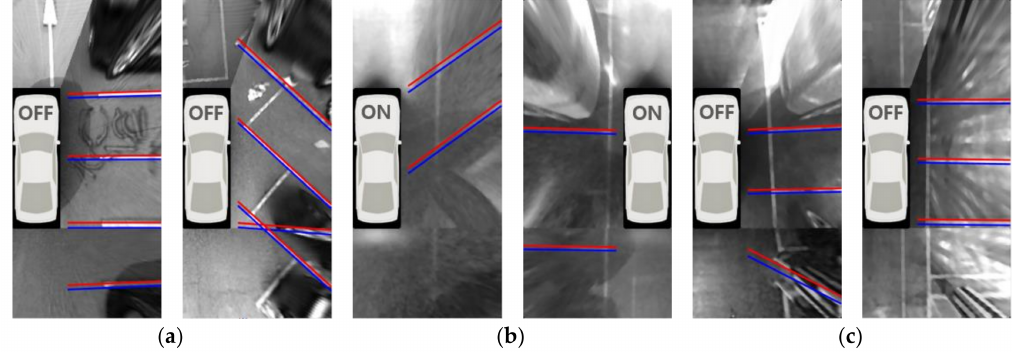
Figure 5. Separating line detection results. ( a ) Daytime; ( b ) Nighttime; ( c )